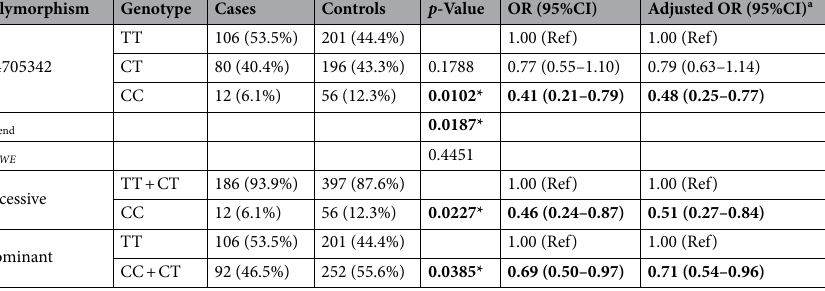
Table 2. Distributions of rs4705342 genotypic frequencies between asthmatic patient and control groups. p- values were calculated by Chi-square without Yates’ correction. P trend p -value for trend, P HWE p -value for Hardy–Weinberg equilibrium. * p < 0.05. a Adjusted for age, gender, and smoking